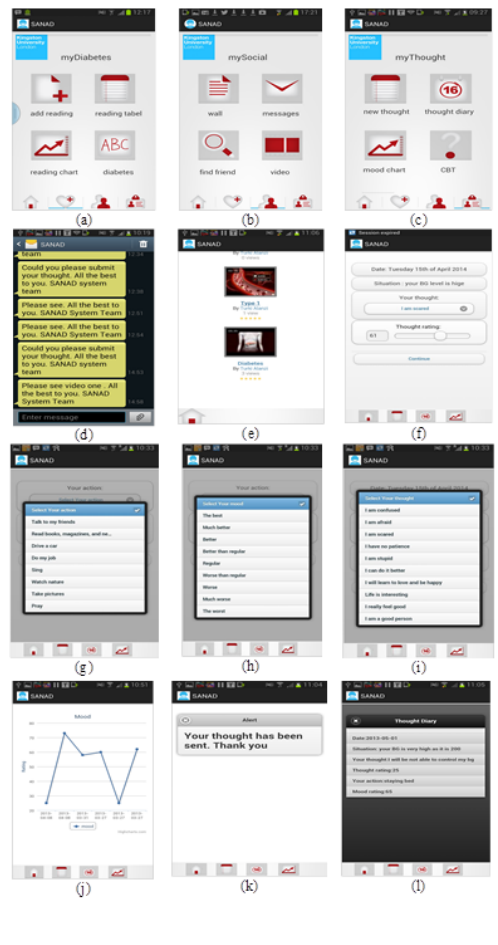
Figure 4. Snapshots of the diabetic patient mobile phone interfaces in the Saudi Arabia Networking for Aiding Diabetes (SANAD)